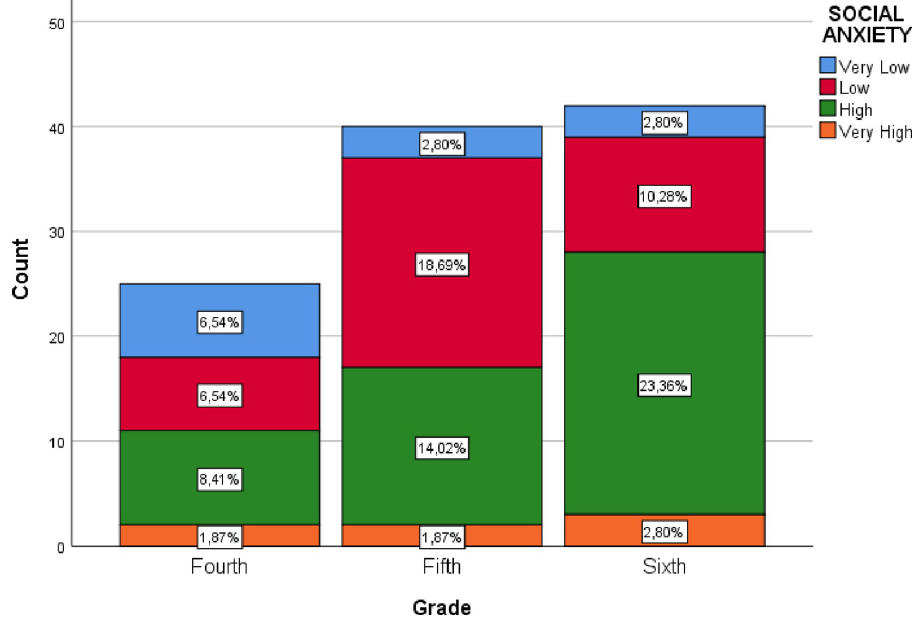
Fig 2. Social anxiety by school